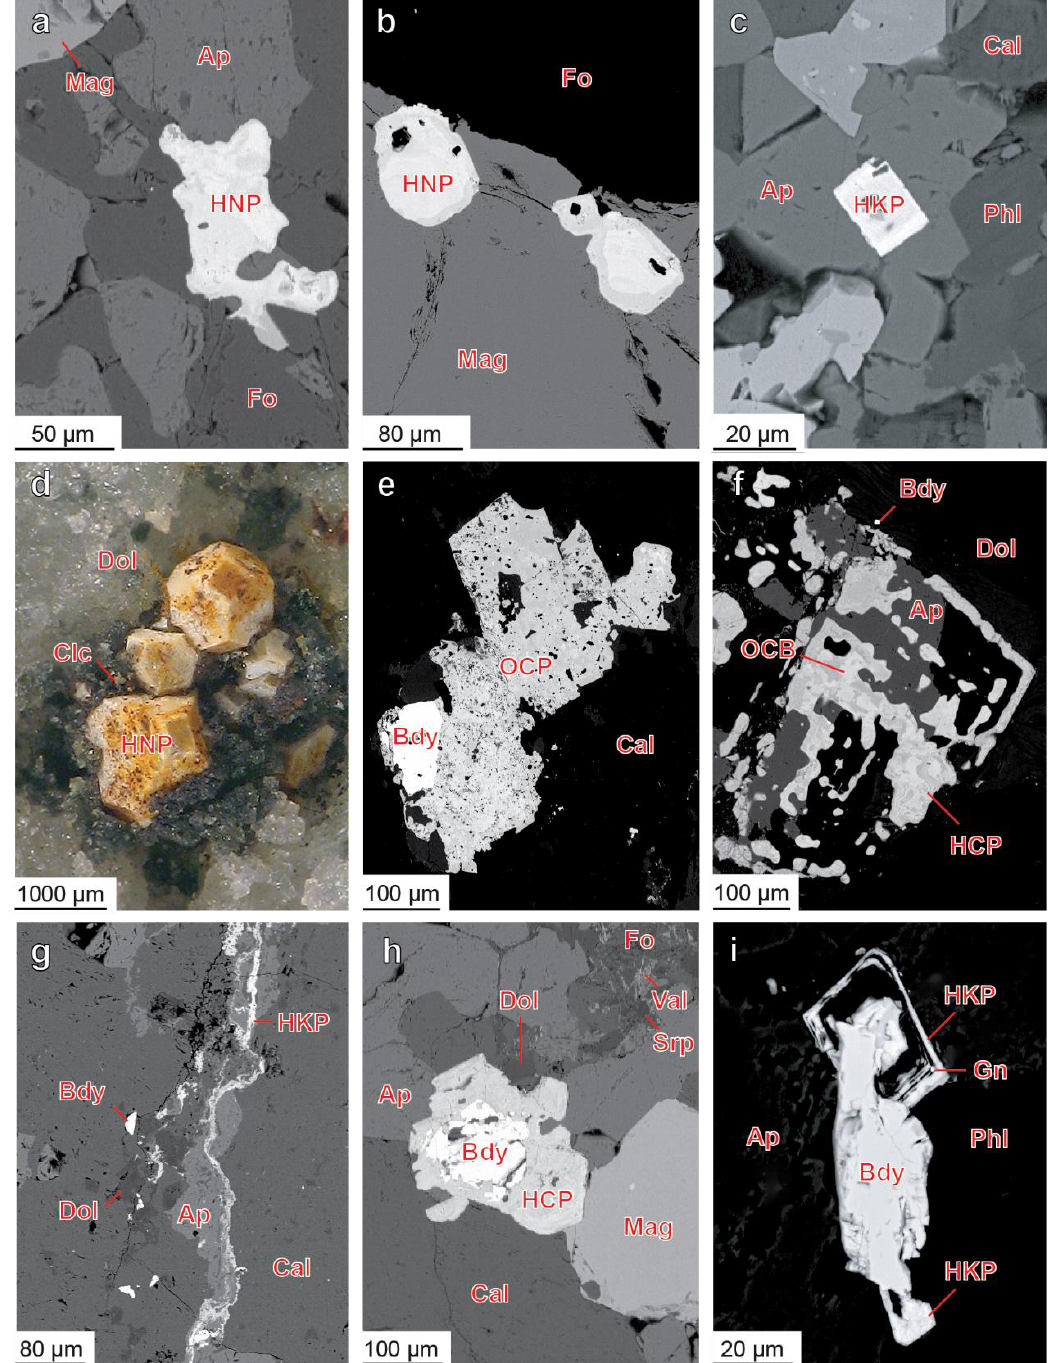
Figure 2. Typical PSM morphology: ( a ) irregularly shaped grain of hydroxycalciopyrochlore in forsterite-magnetite phoscorite 987/2.1; ( b ) drop-like grains of oxycalciopyrochlore in calcite-magnetite-apatite-forsterite phoscorite 987/99.6; ( c ) cubic crystal of hydroxykenopyrochlore in vein calcite carbonatite 963/61.3; ( d ) truncated octahedral crystals of hydroxynatropyrochlore in dolomite carbonatite K-017-4; ( e ) poikilitic metacrystal of oxycalciopyrochlore from calcite-magnetite-forsterite phoscorite 917/318.5; ( f ) skeletal crystal of oxycalciobetafite-hydroxycalciopyrochlore in magnetite-dolomite-serpentine rock 987/198.0; ( g ) veinlets of hydroxykenopyrochlore in vein calcite carbonatite 989/57.8; ( h ) hydroxycalciopyrochlore crystal with baddeleyite relics in calcite-magnetite-apatite-forsterite phoscorite 986/49.6; ( i ) epitaxial overgrowth of hydroxykenopyrochlore on baddeleyite in calcite-apatite-forsterite phoscorite 1009/186.6. Macrophoto ( d ) and back-scattered electron (BSE) images of thin polished sections (the rest). Mineral abbreviations are in Section 2.